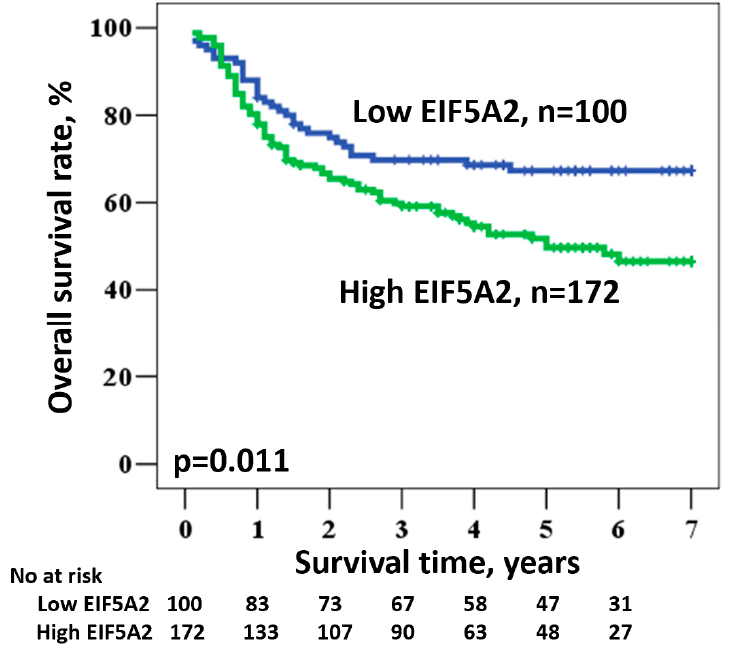
Figure 2. Kaplan–Meier survival of OSCC patients according to EIF5A2 expression.